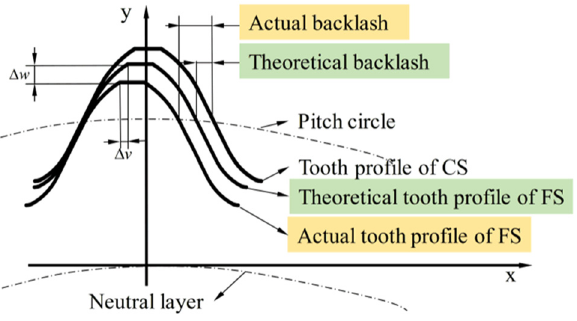
Figure 5: The in fl uence factors